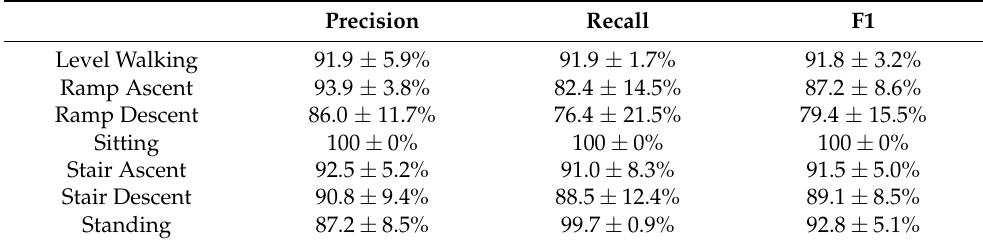
Table 2. Sonomyography classifier mean performance by mode.